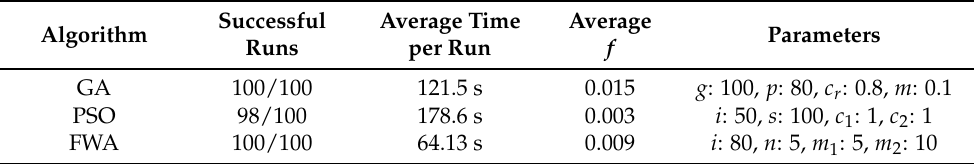
Table 2. Preliminary analysis of stochastic optimization algorithms—tuned